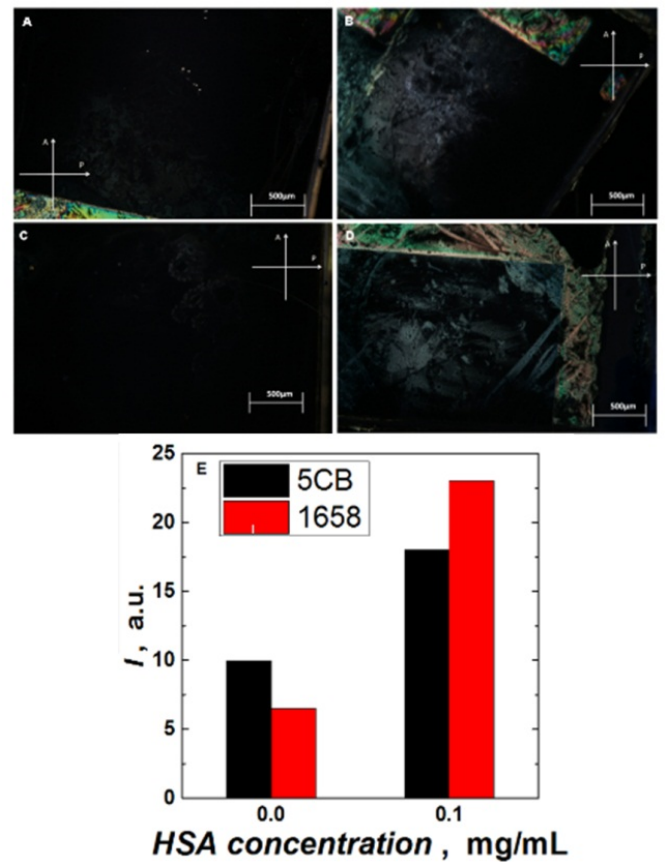
Figure 4. Optical textures of the ( A , B ) 5CB and ( C , D ) 1658 liquid crystals (LCs) recorded for MIP-HSA film-coated slides after immersion ( A , C ) PBS (pH = 7.4) and ( B , D ) 1.5 µM, i.e., 0.1 mg/mL HSA in PBS (pH = 7.4). ( E ) Histogram comparing intensities of light passing through the 5CB and 1658 LCs that were previously immersed in PBS (pH = 7.4) with and without HSA. The HSA calibration curves constructed with the 1658 eutectic LC optical cell, either with the HSA-extracted MIP-HSA or NIP film-coated semitransparent Au film-coated glass slides, are shown in Figure 5. Apparently, the LC MIP-HSA chemosensor linearly responded to the logarithm of HSA concentration in solution in the range of 0.14 to 1 mg/mL, i.e., 2.2 to 15.15 µM, obeying the linear regression equation of Δ I = 83.14 (±0.68) + 53.49 (±2.97) × log c , mg/mL with a correlation HSA coefficient R 2 = 0.9954. At a signal-to-noise ratio of 3, the LOD was 148 µg/mL (2.2 µM) HSA.